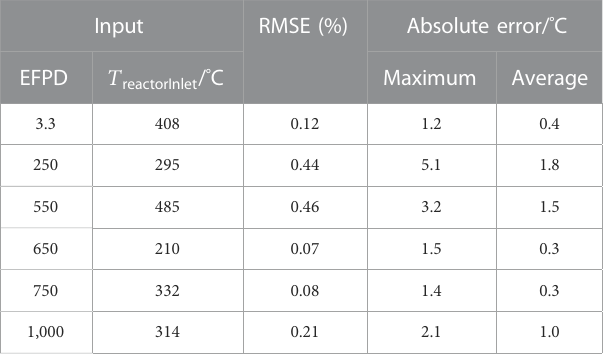
TABLE 5 Comparison between ROM and CFX (monolith